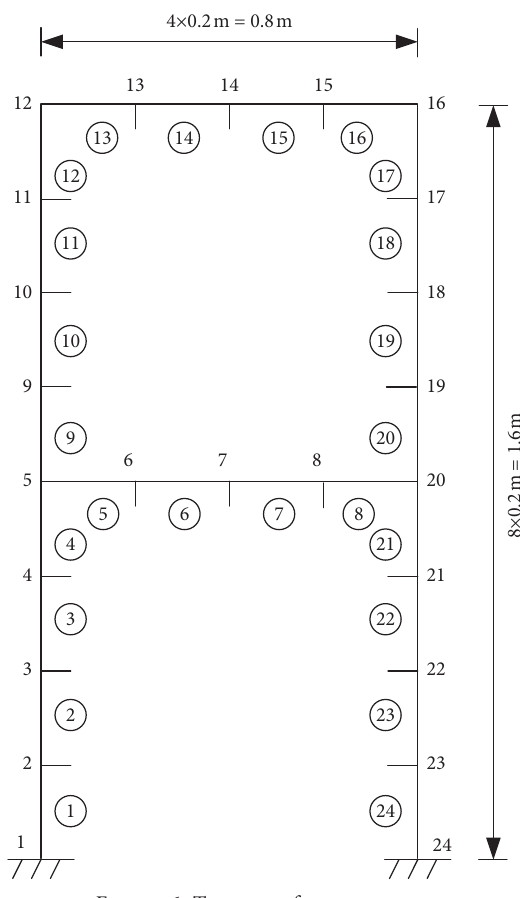
Figure 6: Two-story frame